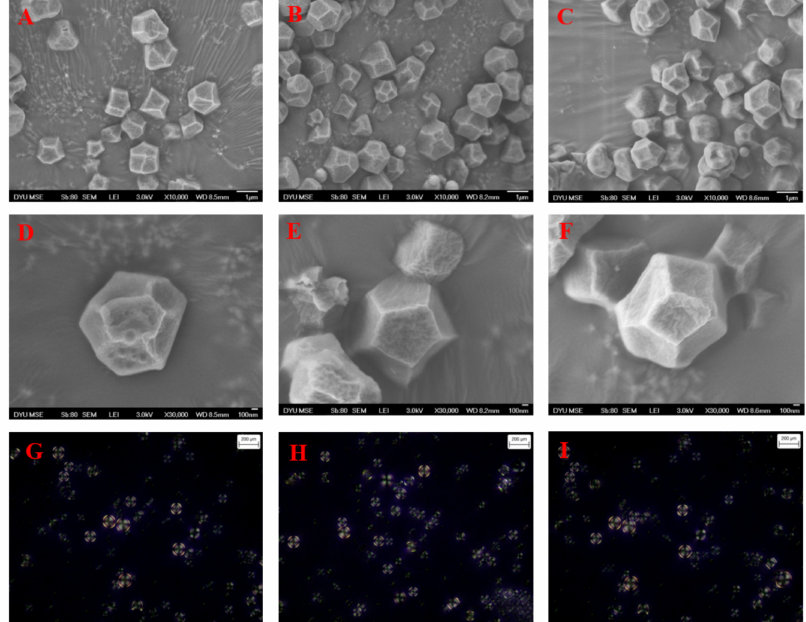
Figure 1. Scanning electron microscopy ( A – F ) and polarized light microscopy ( G – I ) of djulis starch by the three treatment procedures. Hydrochloric acid isolation procedure (HP) ( A , D , G ); Deionized water isolation procedure (WP) ( B , E , H ); and the sodium hydroxide isolation procedure (NP) ( C , F , I